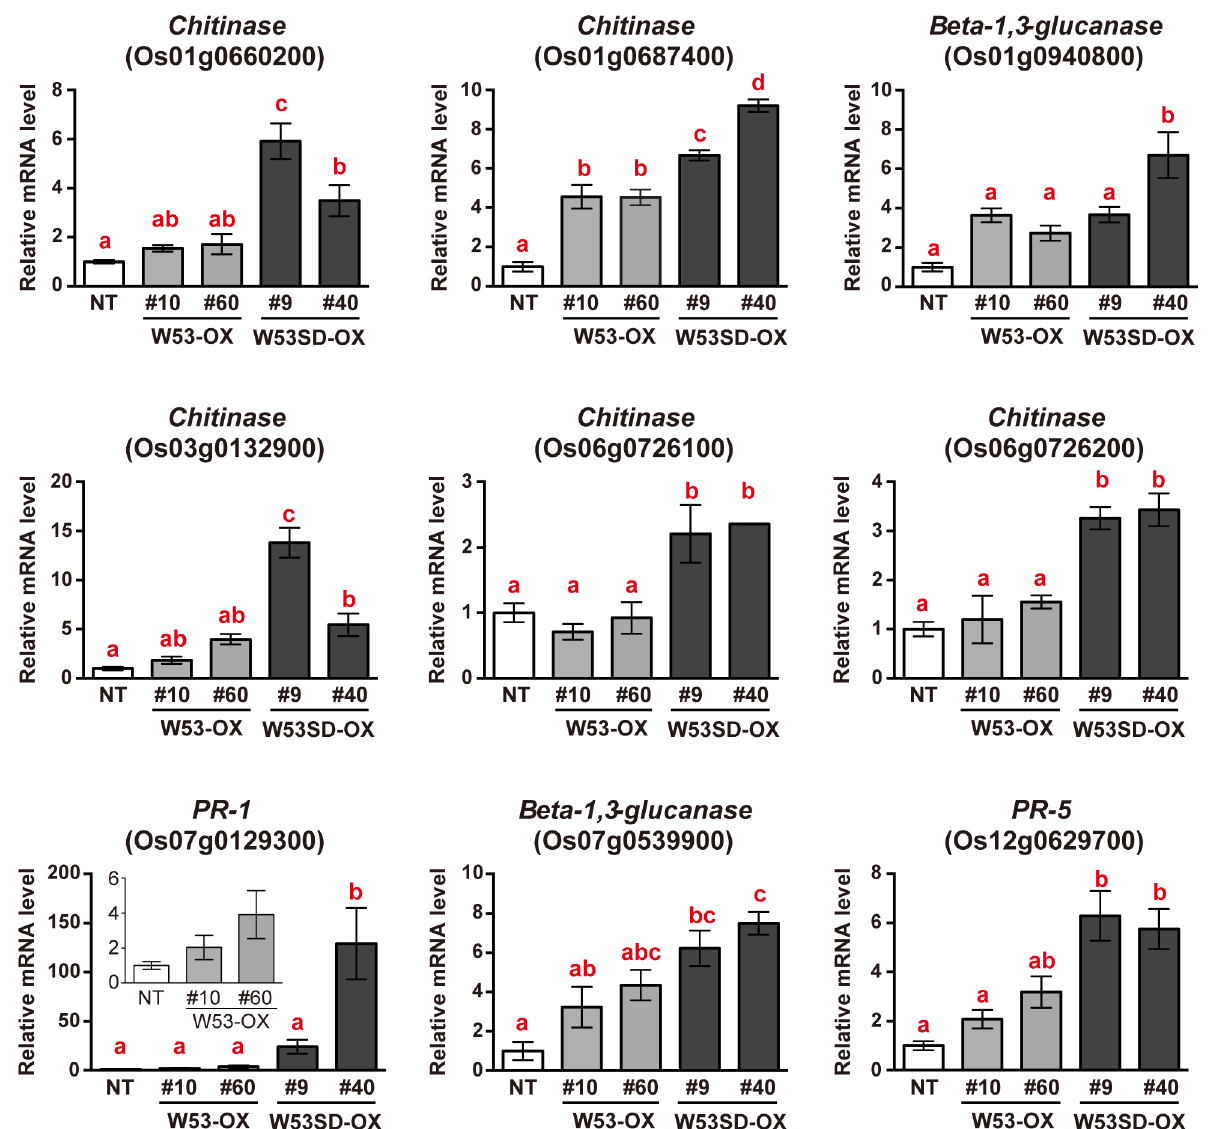
Figure 5. Expression analysis of defense-related genes belonging to group I upregulated genes in W53SD-OX rice plants. qRT-PCR analysis was performed using total RNA isolated from uninfected rice leaves. Values indicate relative mRNA levels normalized to the expression of the UBQ gene (n=3); bars indicate the standard error of the mean. Three independent experiments were performed, and a representative result is shown. Statistically different data groups are indicated using different letters ( p , 0.05 by One-way ANOVA with Tukey post hoc test). NT, non-transformed control; OX, OsWRKY5 3-overexpressing rice plants; SD-OX; OsWRKY53SD -overexpressing rice plants.